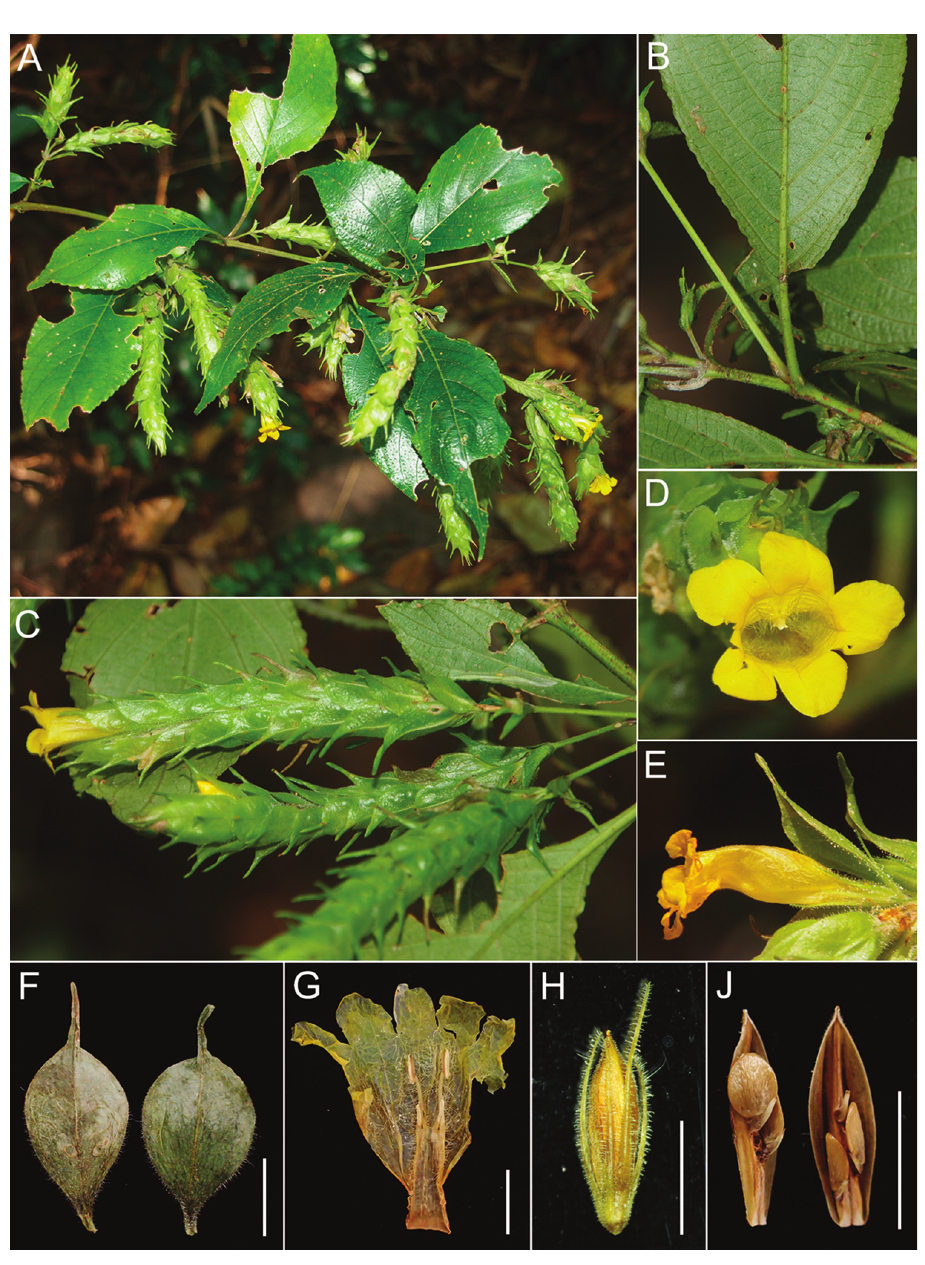
Figure 2. Strobilanthes namkadingensis Soulad. & Tagane. A flowering branch B abaxial leaf surface C inflorescence D flower E side view of corolla F floral bracts G corolla opened out H fruit with calyx J longitudinal section of capsule showing seeds (from Tagane et al. L426 , FU). All scale bars: 5